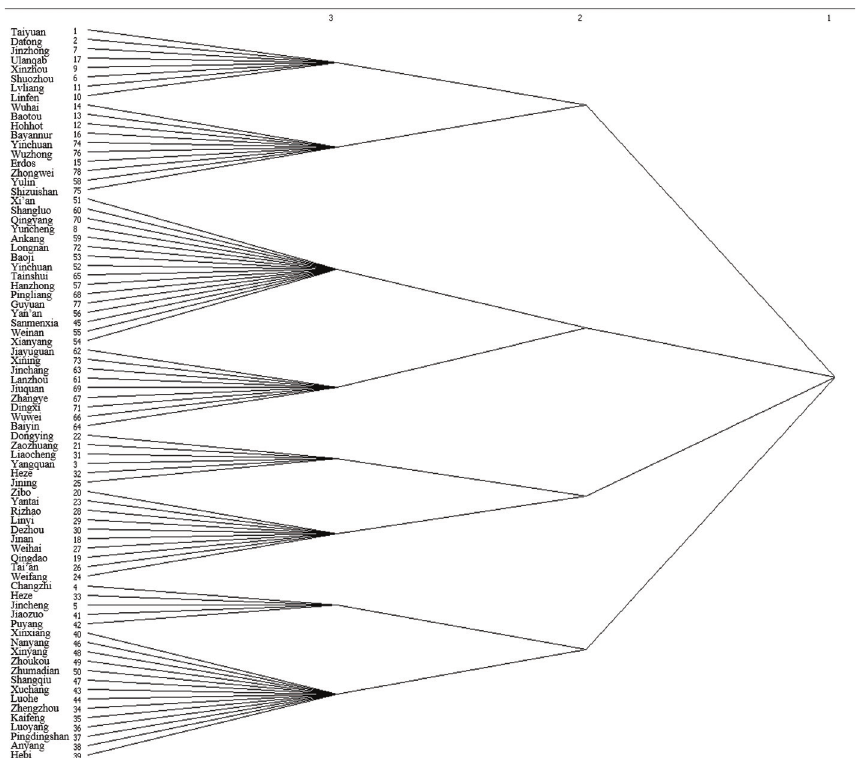
Figure 12: Cohesive subgroups of city networks in the Yellow River basin.